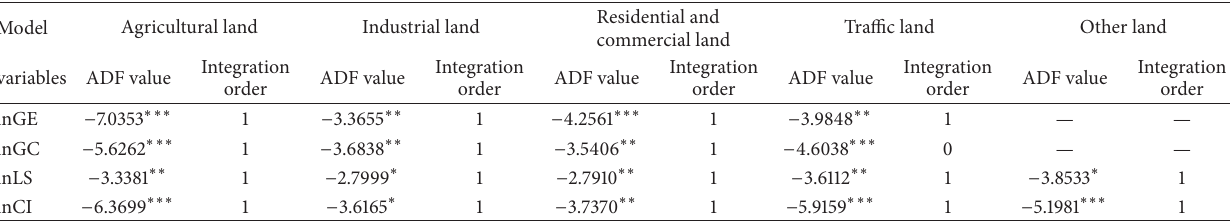
Table 7: ADF values and integration orders of variables in each model.